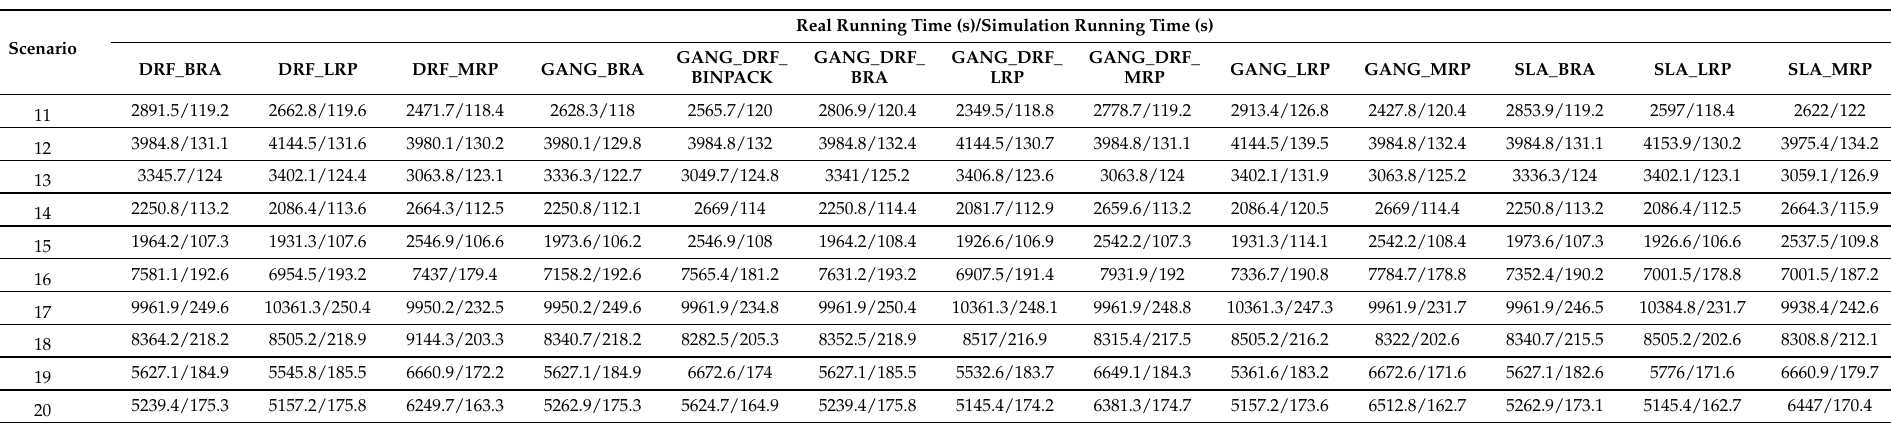
Table 3. Real and simulation running times under JobQueue workloads and changeable